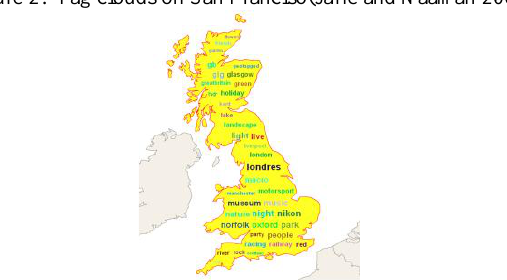
Figure 3. The taggram method(Nguyen and Schumann 2010)- a layout algorithm that adapts the shape of a tag cloud to an arbitrary geometric region.